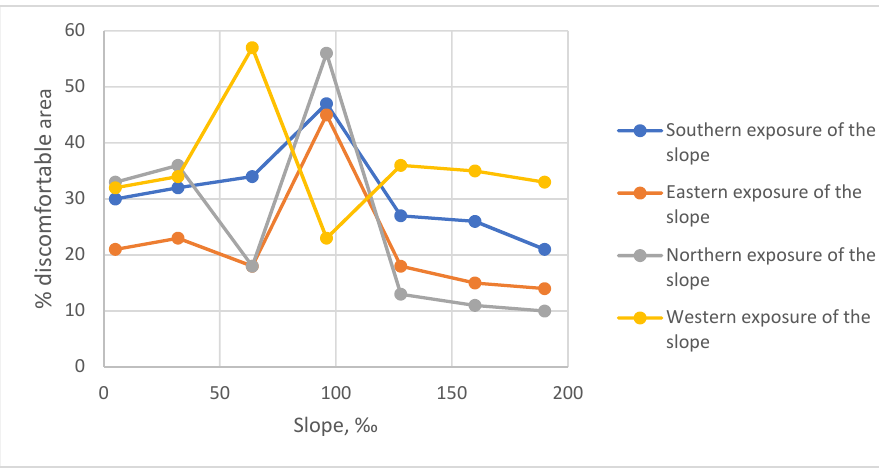
Figure 14. Dependence of k on the slope gradient for the sporadic type of development.